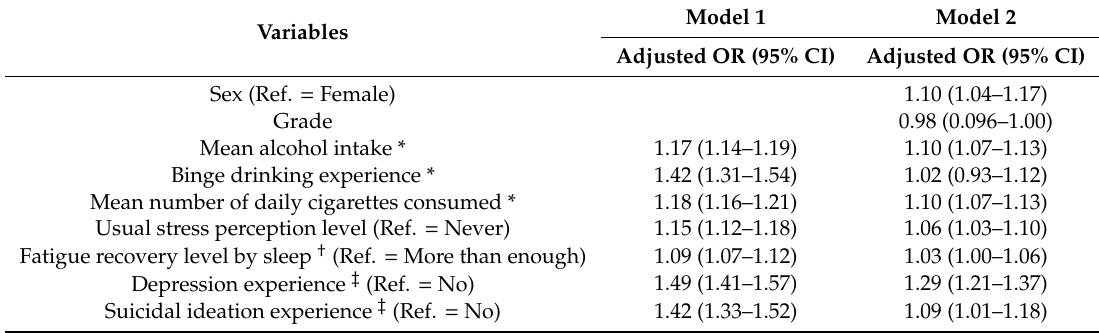
Table 5. The adjusted association of tooth fracture experience related to health-risk behaviors by complex-sample multivariable logistic regression